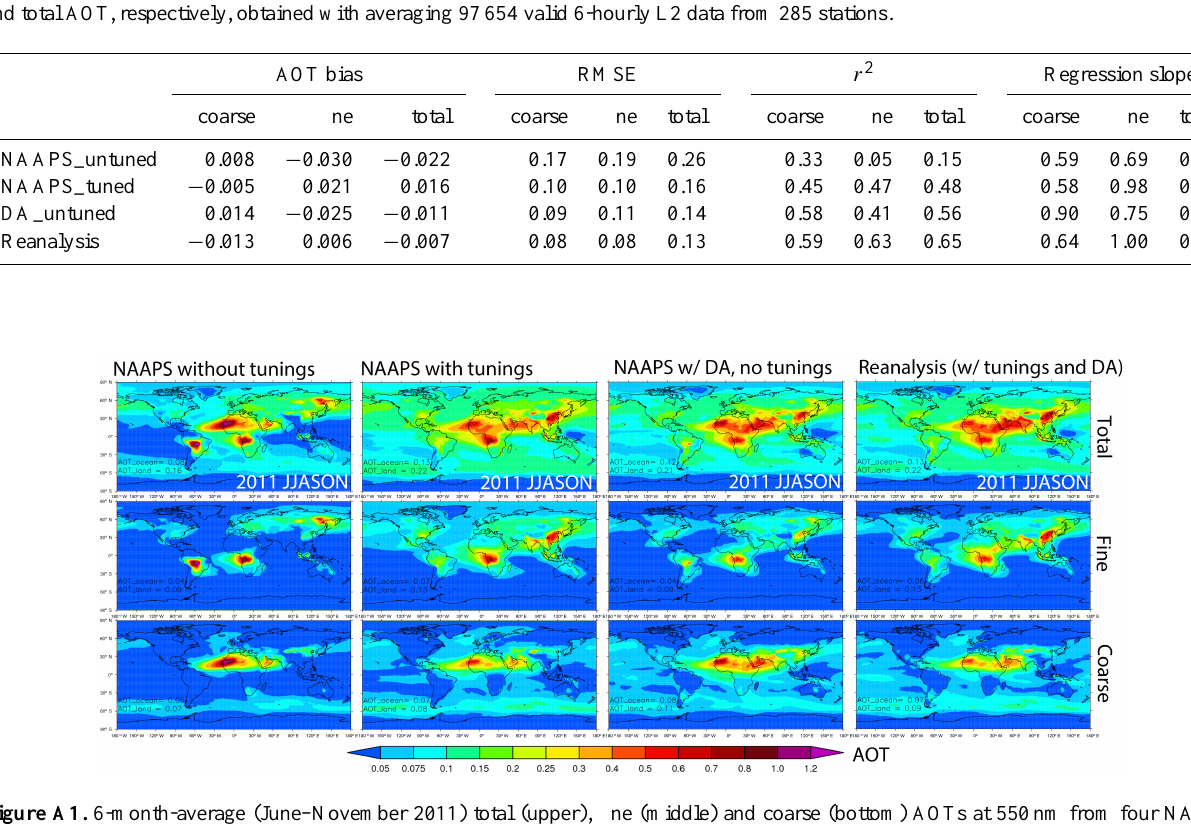
Table A1. Statistics of the coarse, fine and total AOTs at 550nm from four model runs compared with AERONET L2 data. The four model runs are from four different model configurations, including NAAPS without sources and sinks tuning, NAAPS with tuning, NAAPS without tuning but with AOT data assimilation, and the reanalysis version, which is with both the tuning and the AOT assimilation. The comparison is based on 1-year time period (December 2010 to November 2011). The global AERONET mean is 0.085, 0.102 and 0.187 for coarse, fine and total AOT, respectively, obtained with averaging 97654 valid 6-hourly L2 data from 285 stations.